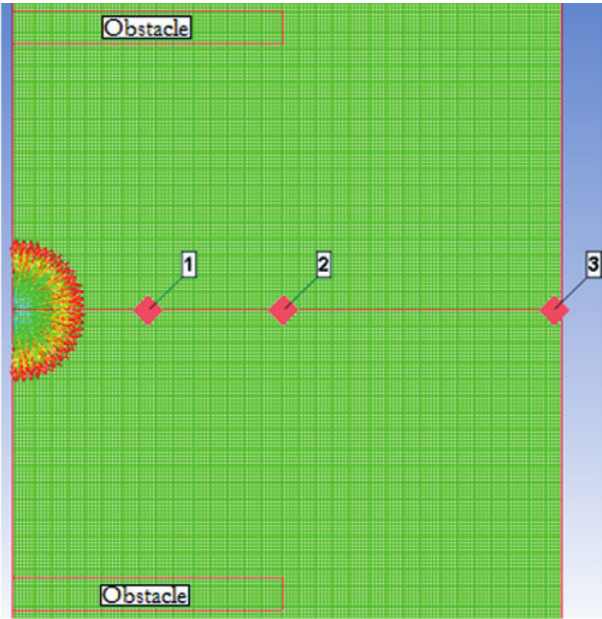
Figure 4 Mesh size of 50mm and gauges positioning along the